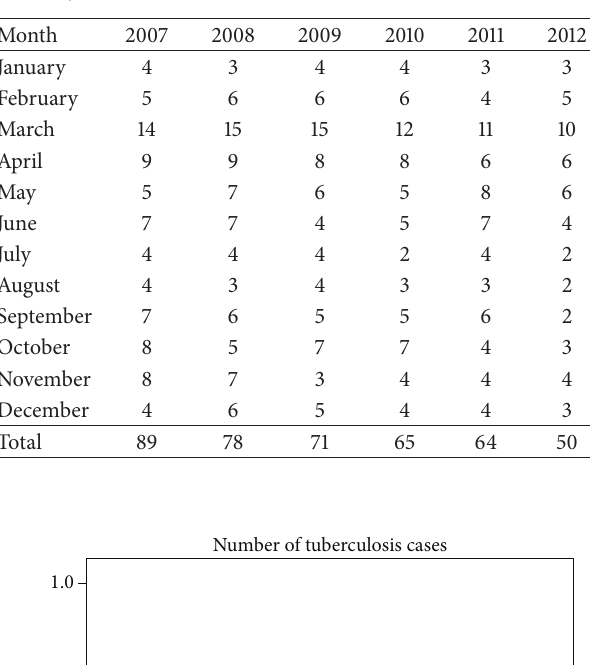
Table 2: Monthly tuberculosis incidence during the study period ( 𝑛 = 417 ).